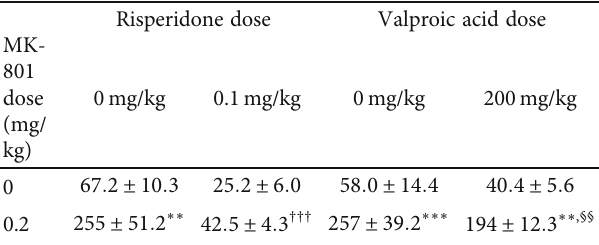
Figure 3: Alterations of the central travelled distance (a, b) and central duration (c, d) followed by MK-801 injection in the open fi eld for mice treated with risperidone/valproic acid. Central travelled distances and duration are shown in meters and seconds, respectively. Vertical bars (for clarity, only the upper or lower portions shown) represent standard errors of the means. Statistically signi fi cant di ff erences between groups were evaluated by ANOVA. ∗ p < 0 : 05 , ∗∗ p < 0 : 01 , and ∗∗∗ p < 0 : 001 vs. vehicle +vehicle; # p < 0 : 05 , ## p < 0 : 01 , and ### p < 0 : 001 comparing with vehicle +MK-801; § p < 0 : 05 , §§ p < 0 : 01 , and §§§ p < 0 : 001 vs. valproic acid + vehicle. Table 1: Comparisons of risperidone and valproic acid e ff ects on MK-801-induced